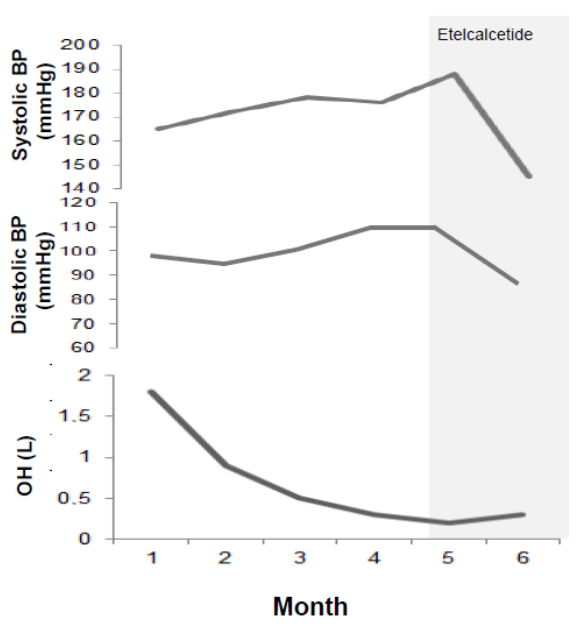
Figure 3. Unrelated blood pressure response to dry weight reduction in our patient before starting Etelcalcetide. OH: overhydration at body composition monitoring (BCM).